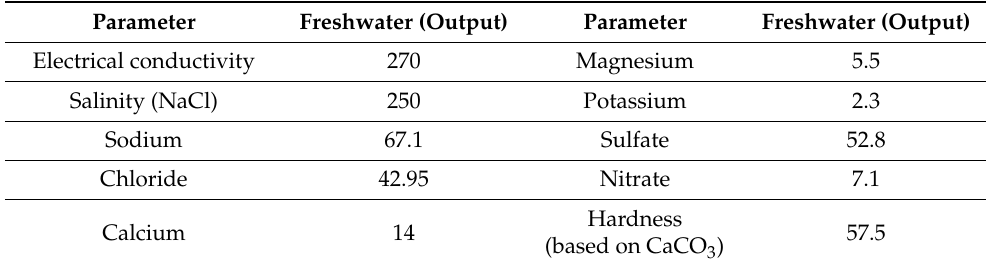
Table 3. Quality parameters of the water produced by the solar distillation unit. Parameter Freshwater (Output) Parameter Freshwater (Output) Electrical conductivity 270 Magnesium 5.5 Salinity (NaCl)